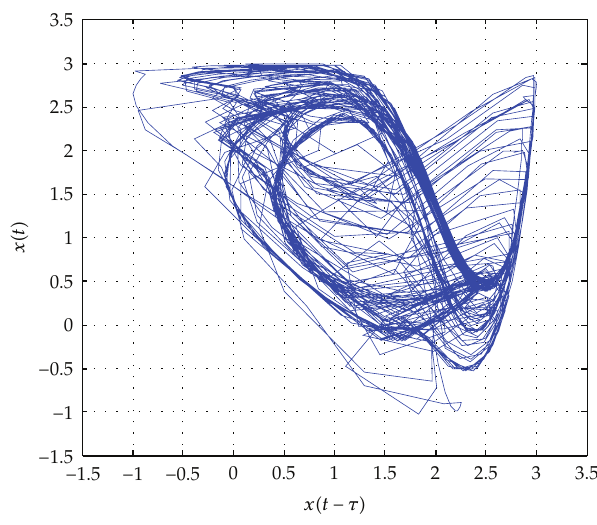
Figure 5: A chaotic attractor of the delayed memristive system (cid:2) 3.1 (cid:3) .